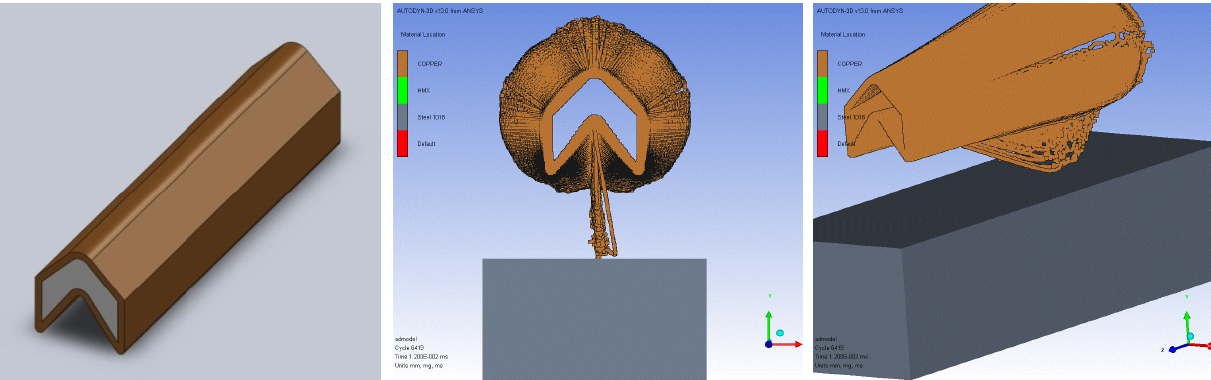
Figure 1. 1,200 gr/ft. Linear Shaped Charge (LSC) drawn before being imported into AUTODYN ® , LSC detonation at OSD 12 µs after detonation from left to